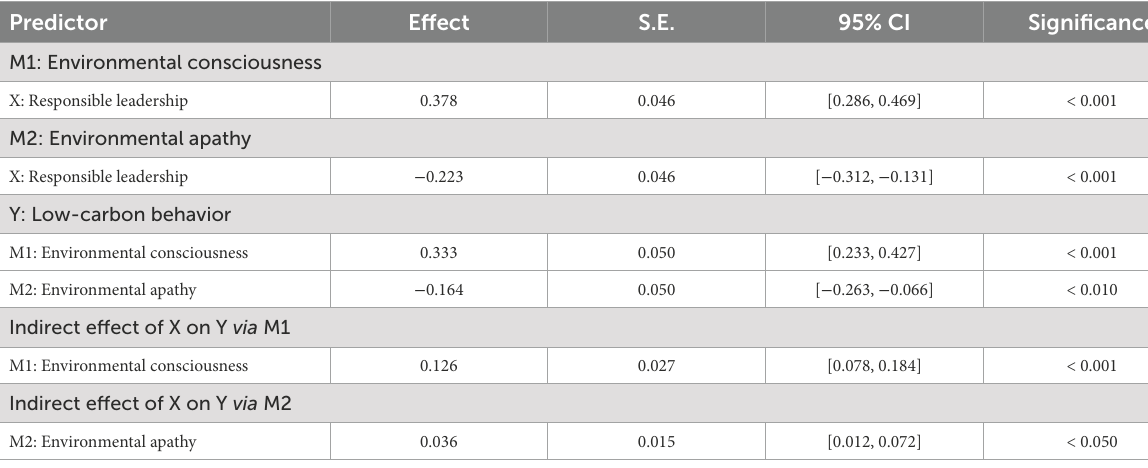
TABLE 4 Regression results for directing and mediating effects.